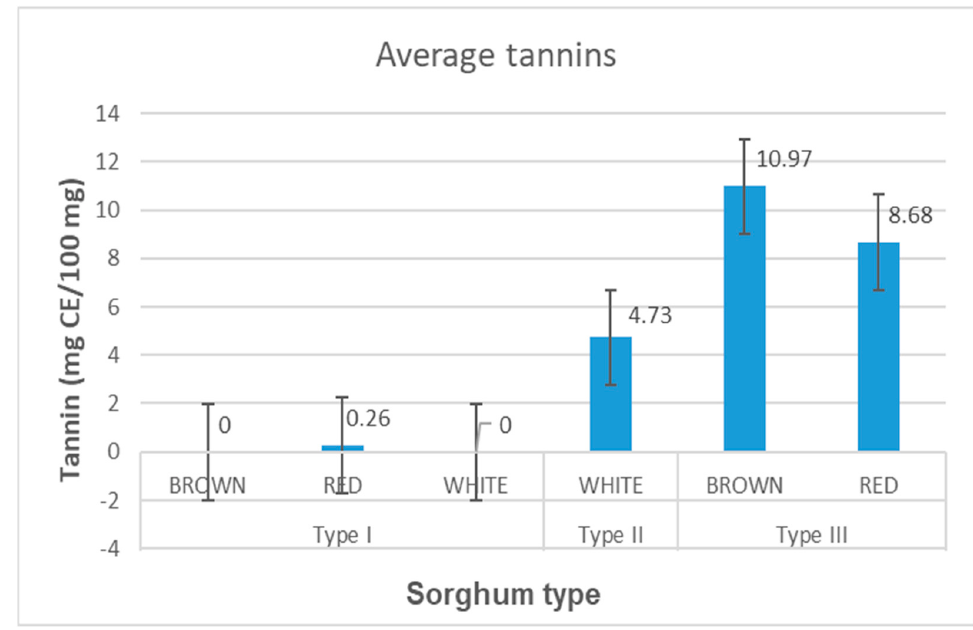
Figure 1. Mean tannin content for different grain colors and sorghum types.